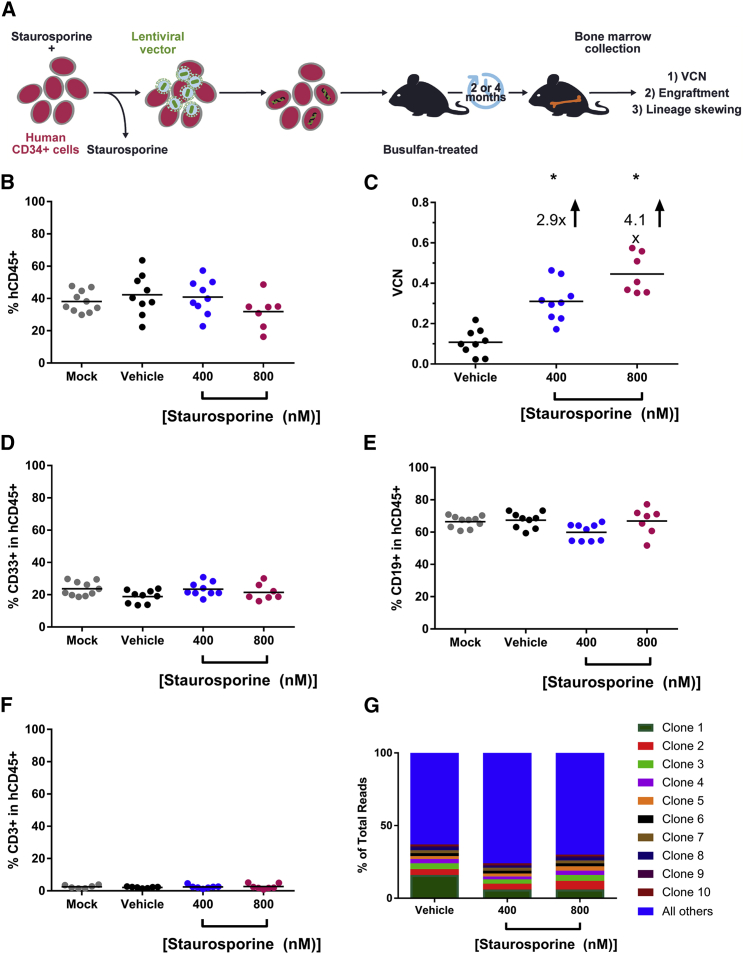
Staurosporine Increases the Proportion of Genetically Modified Long-Term Repopulating Cells(A) Schematic of NSG transplant. Cells were transduced after pre-treatment with vehicle or staurosporine (400 nM or 800 nM) and then transplanted via tail-vein injection into sub-lethally myeloablated NSG recipients. Four months post-transplantation, BM was analyzed for VCN and engraftment. (B) Engraftment of long-term repopulating human cells in NSG assessed by presence of human CD45. Each dot represents an individual mouse. (C) VCN of engrafted human cells in BM of NSG mice. (D) Assessment of in vivo myeloid differentiation of human cells (CD33+). (E) Assessment of in vivo B cell differentiation. (F) In vivo T cell differentiation. (G) Top 10 clones captured via integration site analysis (ISA) from BM of transplanted animals. Note that clones 1–10 represent different integration sites within each transplant arm. *p < 0.0001.